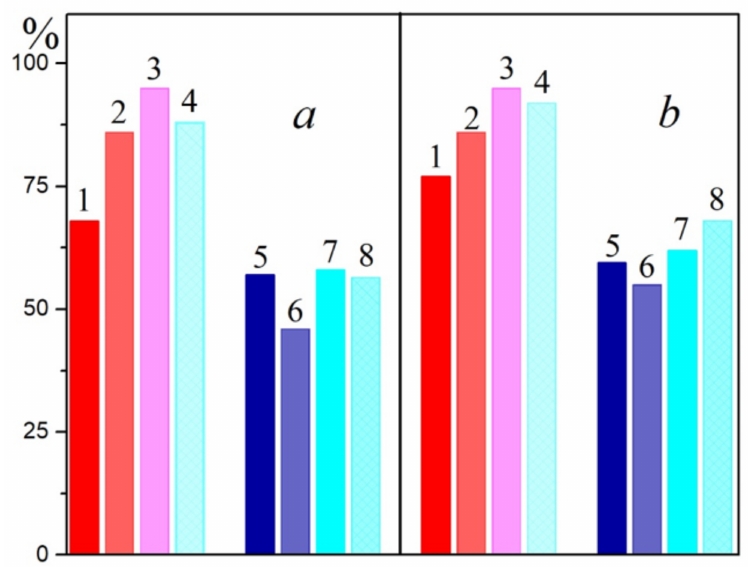
Figure 5. Diminution (%) of the long-wavelength Q y band of BChl (BChl850/830) in the LH2 complex ( a ) and in the LH3 complex ( b ) from T . sibirica having different carotenoid contents (1—control; 2— 80%; 3–40%; 4–10%) under illumination for 30 min in the presence of 50 µ M RB (1, 2, 3, and 4) or blue light (5, 6, 7, and 8).